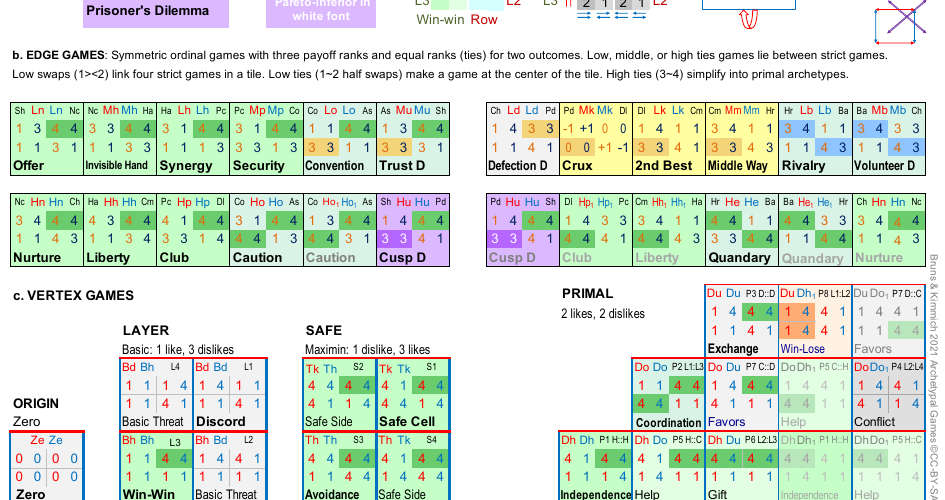
Bands of games slide across layers Table and and switch rows or layers columns, e.g. HaCh><PcSh